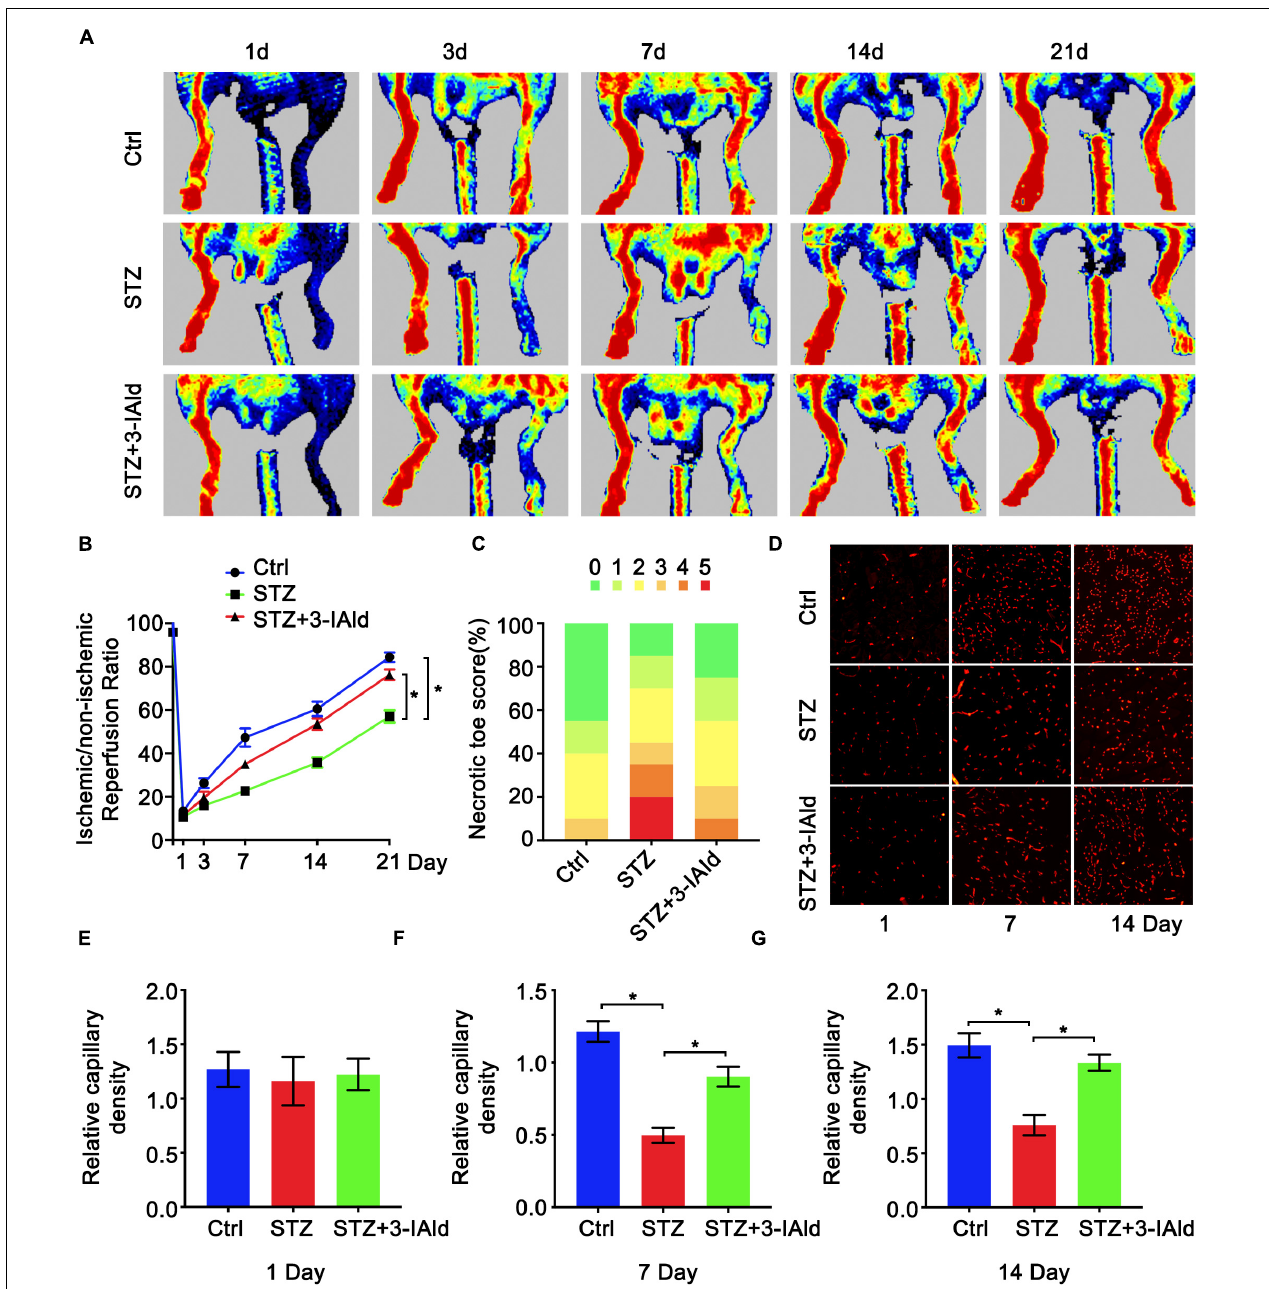
FIGURE 1 | 3-IAld improves blood perfusion and ischemic angiogenesis in diabetic HLI. (A) Original laser Doppler perfusion images (LDPIs) displaying hindlimb perfusion in each group at 1, 3, 7, 14, and 21 days after ligation of the femoral artery. (B) Perfusion recovery in mice of the control, STZ and STZ + 3-IAId groups at 1, 3, 7, 14, and 21 days after surgery. n = 10 for each group. (C) Necrotic toe score determined at Day 21 after ischemic injury. n = 7 for each group. (D) Representative immunofluorescence images showing CD31 density in gastrocnemius muscle at 1 and 14 days after artery ligation. (E–G) Capillary density was evaluated as the ratio of capillary number per field; n = 6 for each group. Data are presented as the mean ± SEM. * P <